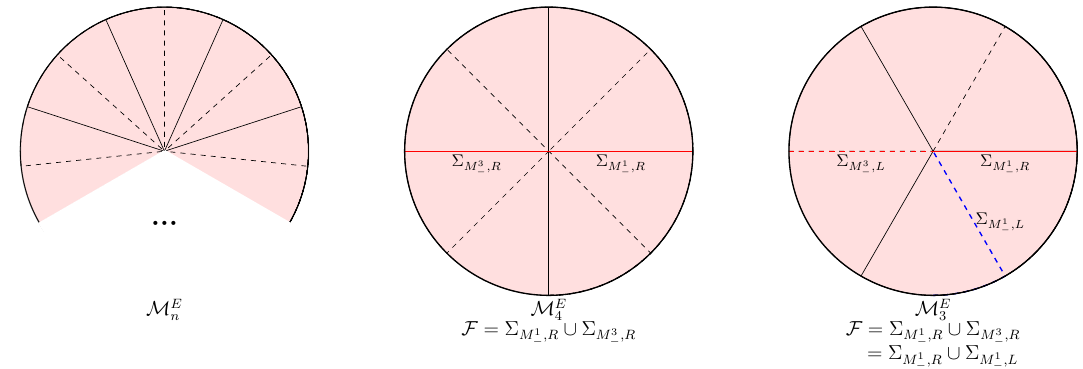
Figure 6 . All panels: examples for various n of the Euclidean manifolds M E rotated to obtain the real-time saddle M n . We take these to have replica and conjugation sym- metries. Each conjugation symmetry leaves invariant some combination of dashed and solid black surfaces. As a result, the induced metric is real on these surfaces and the Euclidean-signature extrinsic curvature is imaginary. Thus Wick rotation to Lorentz signature gives real Cauchy data on these surfaces. Center and Right: for the cases n = 4 and n = 3 , we may consider symmetries that act simultaneously by complex conjugation and by reflection across the red surfaces F